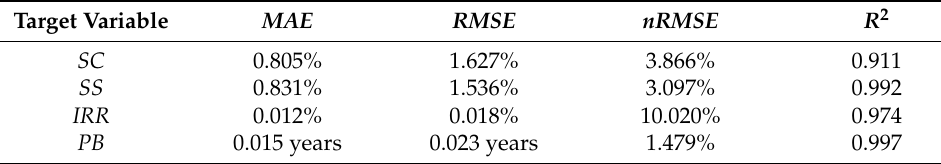
Table 9. Error metrics of the predicted SS , SC , IRR and PB by the QR models. Target